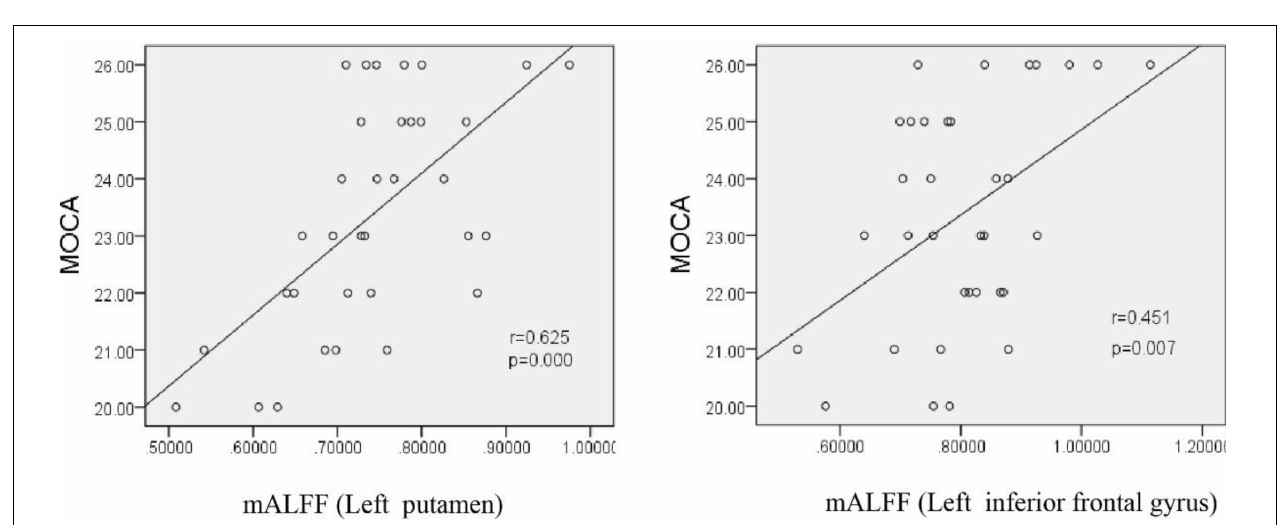
FIGURE 9 | Correlation between the mALFF value and MoCa score in HA participants. MoCA, montreal cognitive assessment scale; mALFF, amplitude of low frequency fluctuations.